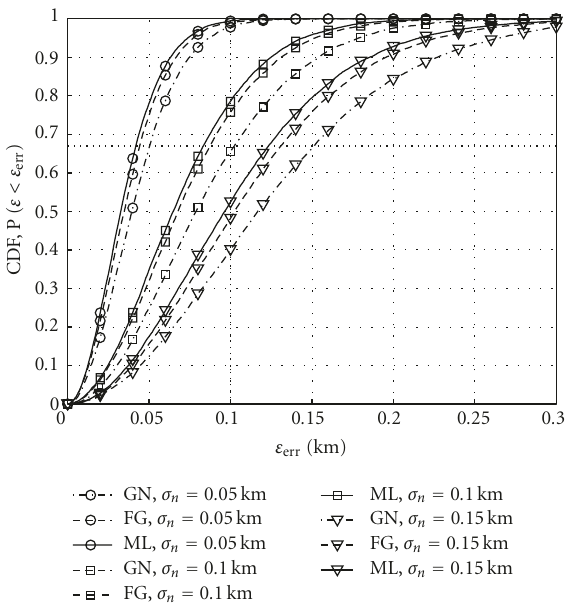
Figure 12: CDF for di ff erent algorithms, R = 3km, N BS = 4.